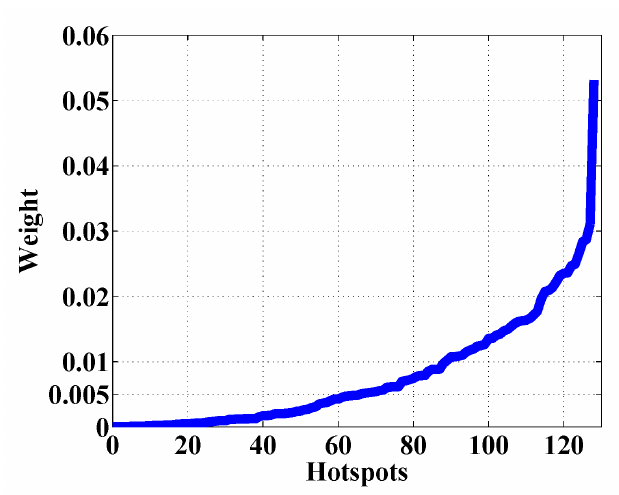
Figure 1. Weight distribution of all hotspots